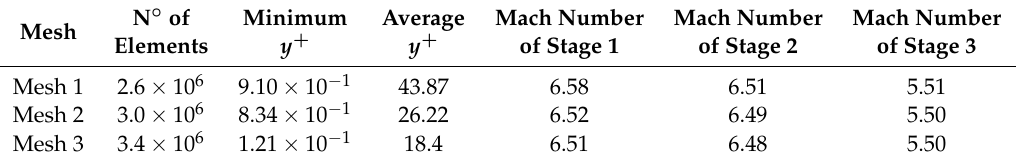
Table 4. Number of elements, minimum and average y + values and Mach numbers of stages 1, 2 and 3 of Mesh 1, Mesh 2 and Mesh 3 for AoA = 0 ◦